Question: Write a descriptive caption for this figure.
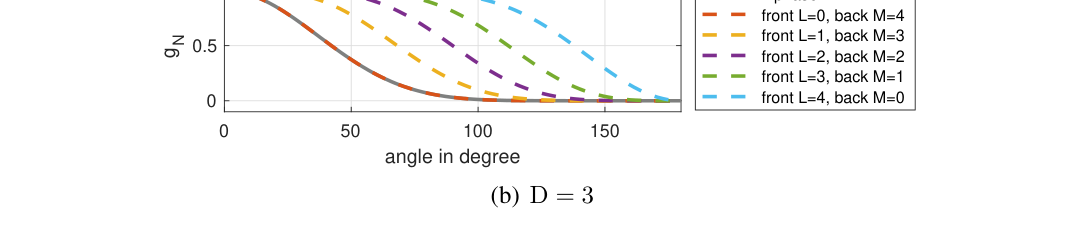
Answer: – Examples for maximally flat designs with L + 1 flatness degrees on axis, and a zero with M + 1 flatness degrees for N = L + M + 1 and for D = 2 and D = 3.